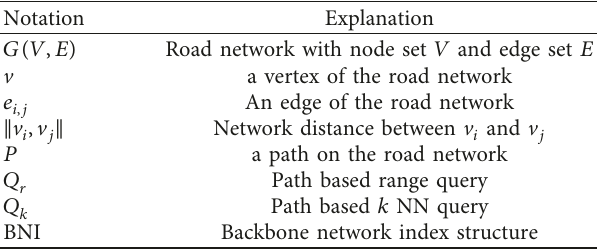
Table 2: Summary of the